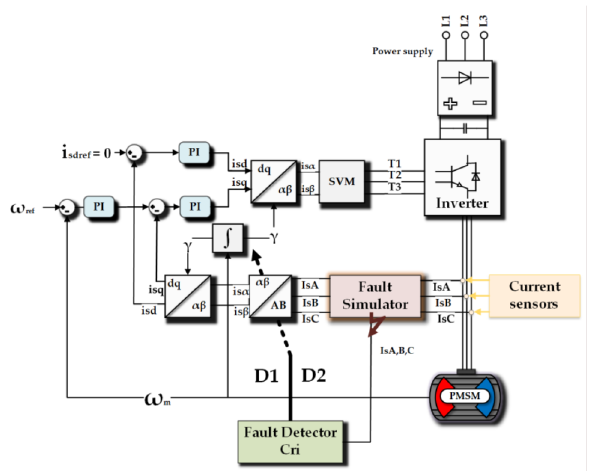
Figure 15. General diagram of field oriented control structure with fault